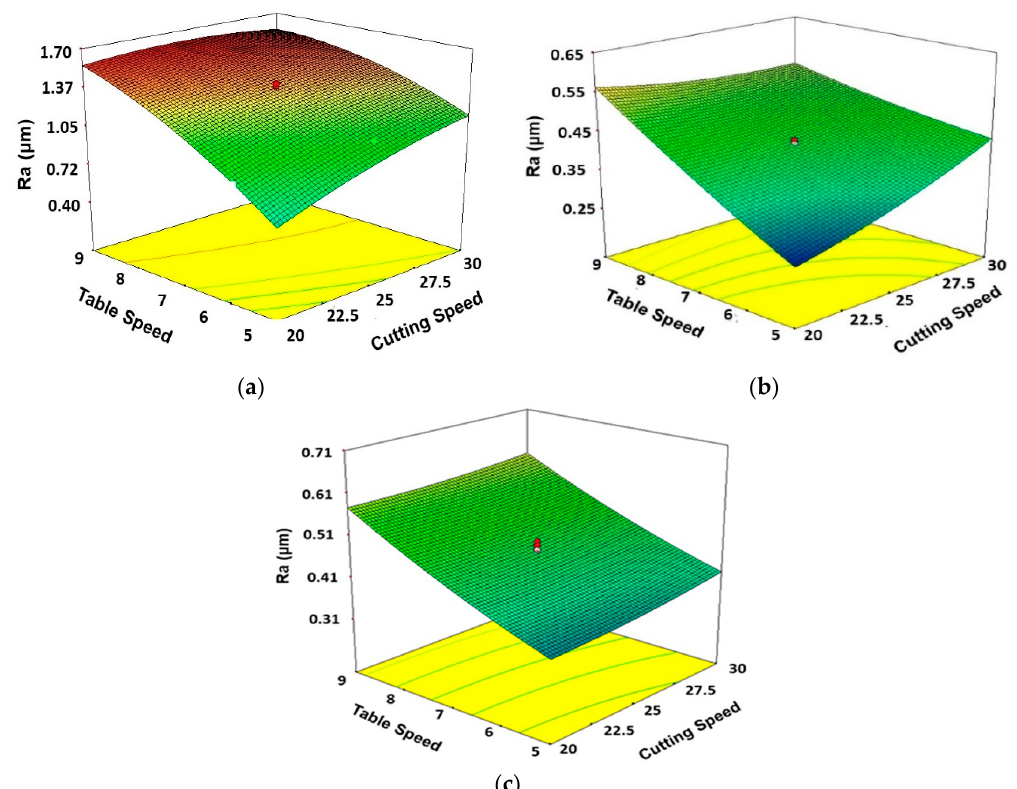
Figure 8. 3D Surface plots showing the effects of cutting speed and table speed on surface roughness for ( a ) Dry, ( b ) Wet, and ( c ) MQL conditions. Units of table speed and cutting speed are ‘m/min’ and ‘m/s’, respectively.